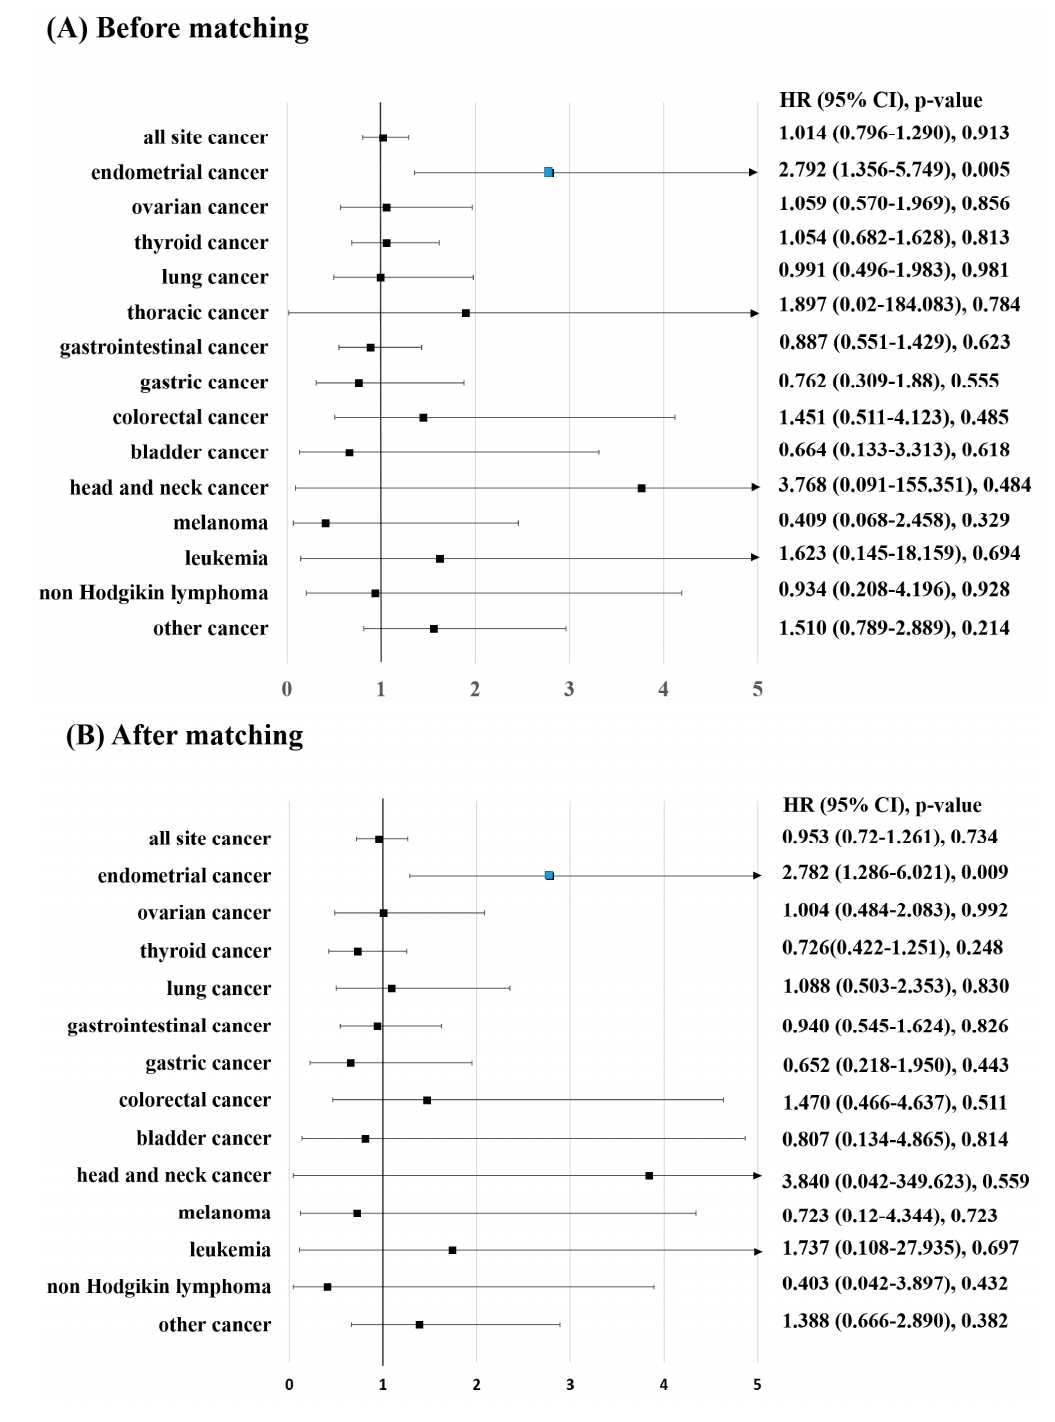
Figure 3. Risk of developing secondary cancer due to long-term tamoxifen use in patients with breast cancer: ( A ) before matching; ( B ) after matching. HR, hazard ratio; CI, confidence interval.